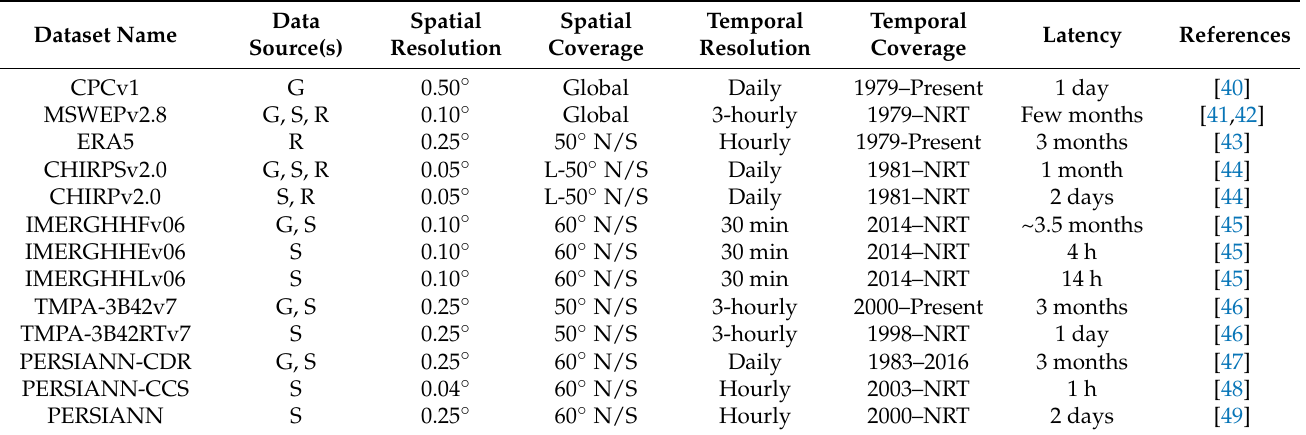
Table 1. Properties of selected GPDs. Abbreviations in the data source represent; G, Gauge; S, Satellite; and R, Reanalysis. Abbreviation in the temporal coverage represent; NRT, Near